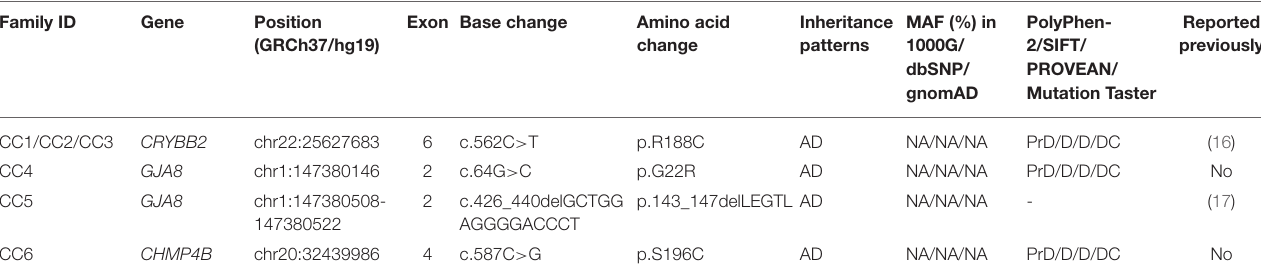
TABLE 1 | Mutations in the CRYBB2, GJA8, and CHMP4B genes were identified in six Chinese Han families with CCs. Family